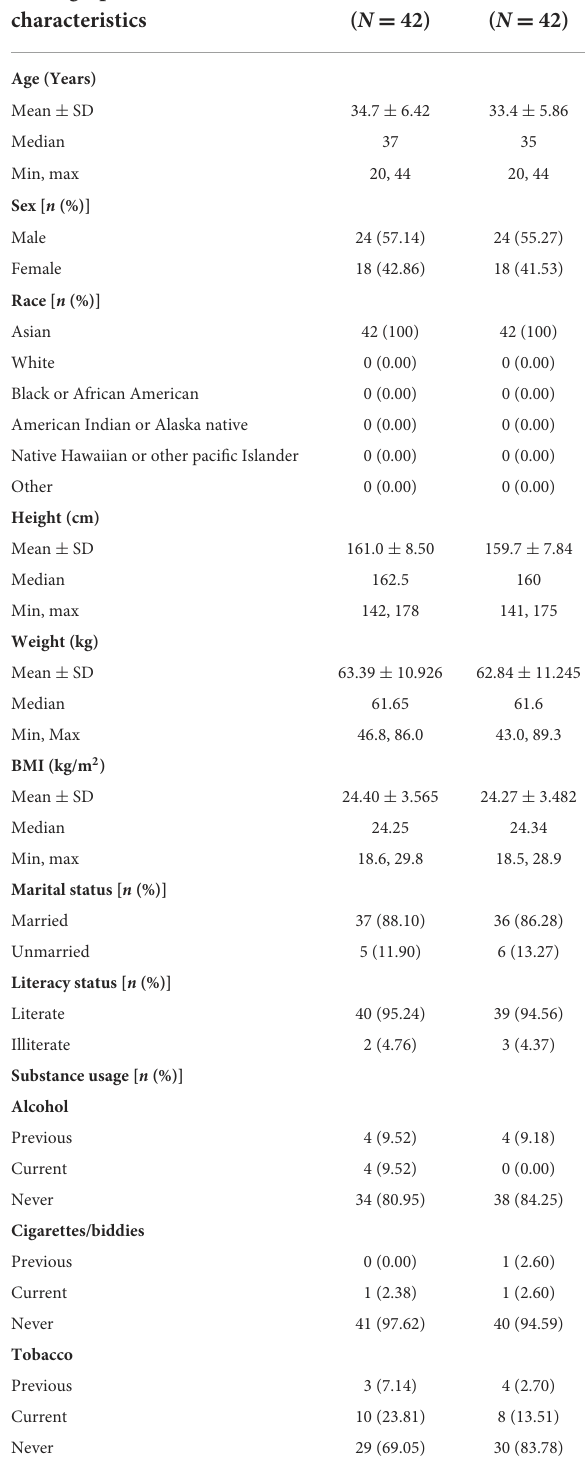
TABLE 1 Summary of the baseline demographic and clinical baseline